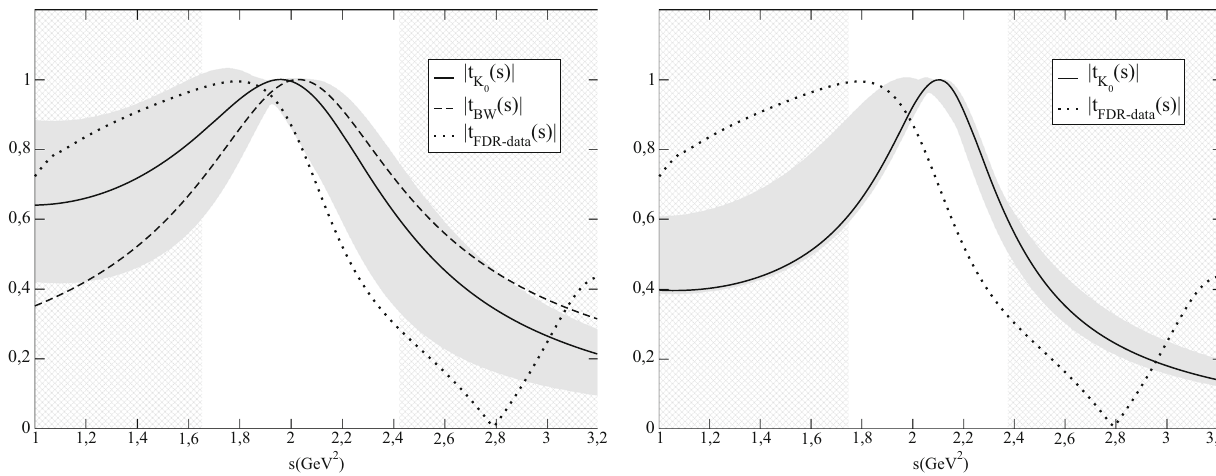
Fig. 1 The dotted line , labeled “FDR-data”, corresponds to the modu- lus of the K π scattering partial wave in the scalar–isospin 1/2 channel, obtained from a fit to data constrained with forward dispersion rela- tions [29]. On the left panel , the dashed line is the Breit–Wigner shape obtainedusingtheresonanceparametersintheRPP.NotethattheBreit– Wigner peak is displaced from the peak in the data. The continuous line is the result of our method, with a Regge pole consistent with that of the Breit–Wigner parameterization, but satisfying the dispersive con-